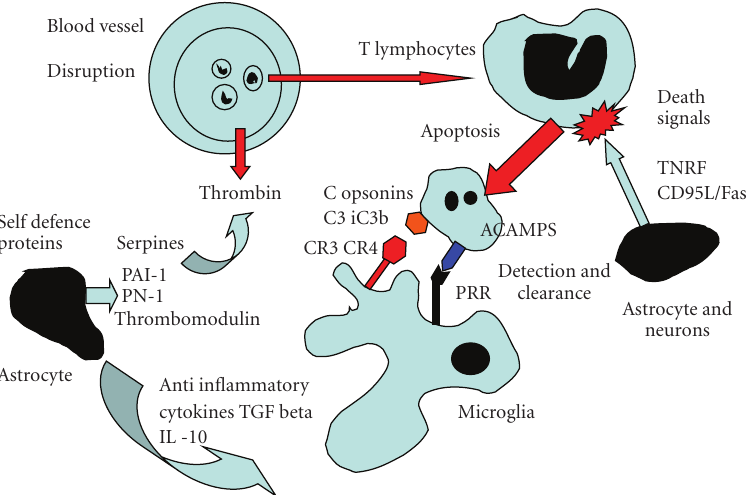
Figure 1: Shows the consequences of disruption of the blood brain barrier BBB. Thrombin is an example of a protein with pathogen protein associated molecular pattern (PPAMPS) released into the neuropil and its neurotoxic e ff ects are countered by the expression of glial “selfdefence” proteins including the serpins (serine protease inhibitors) protease derived glial-nexins PA-1, PN-1. Systemic T cells are identified and targeted by “Death signals” TNF and CD95L/CD95F as expressed by astrocytes and neurons this initiates apoptosis. Apoptotic cells defined as “altered self” by cell surface apoptotic cell associated molecular patterns (ACAMPs) are identified by microglia expressing pattern recognition receptors (PRR) and subsequently cleared from the brain, reducing the severity of the inflammatory response.